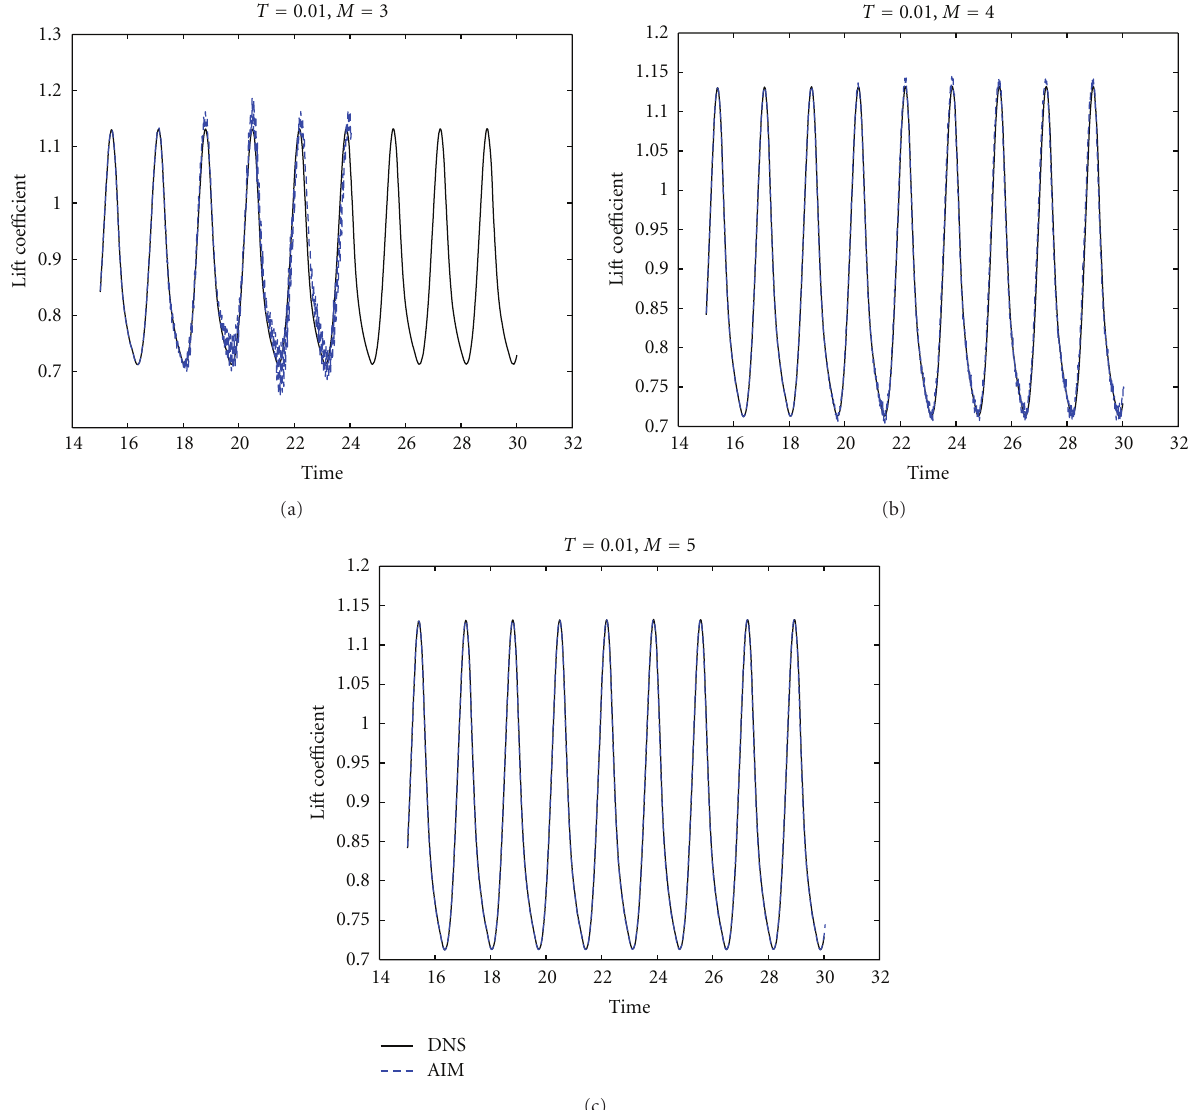
Figure 11: Periodic case: Re = 800. Computed lift coe ffi cient for T = 0 . 01 with various number of M . From top to bottom: M = 3,4, and 5.